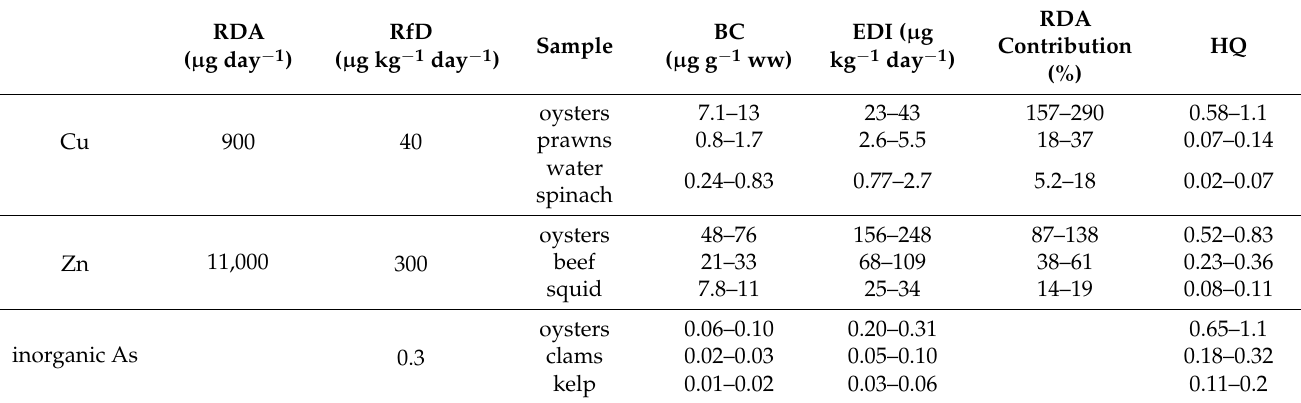
Table 1. The RDA contribution and HQ that related to food